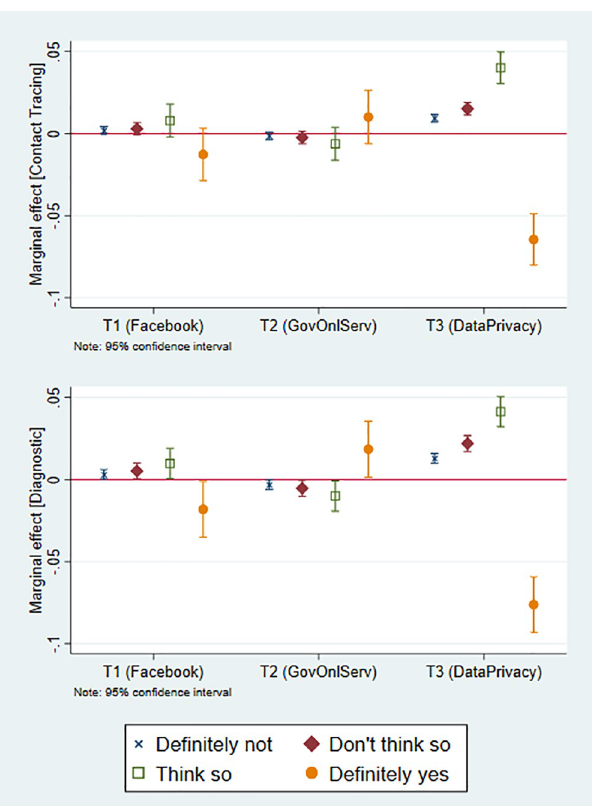
Fig 2. Treatment effects—Ordered logit. These figures show the change in probabilities associated to each treatment for the two dependent variables. Correspond to the margins of the coefficients in columns [1] and [4] in S1 Table.